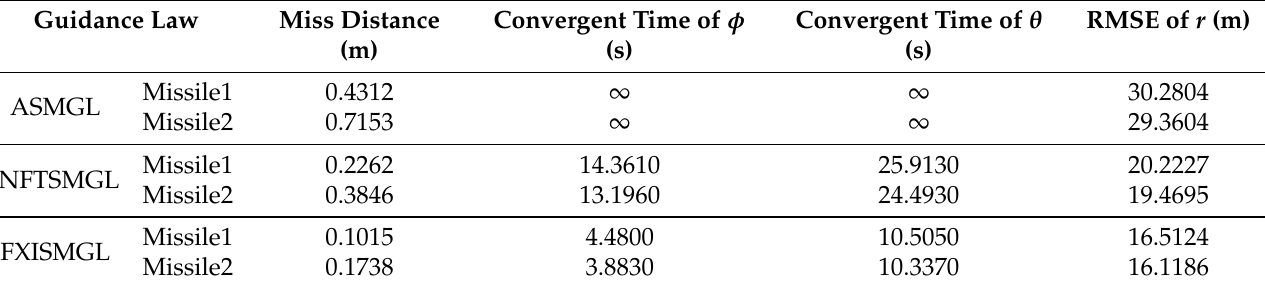
Table 2. Initial